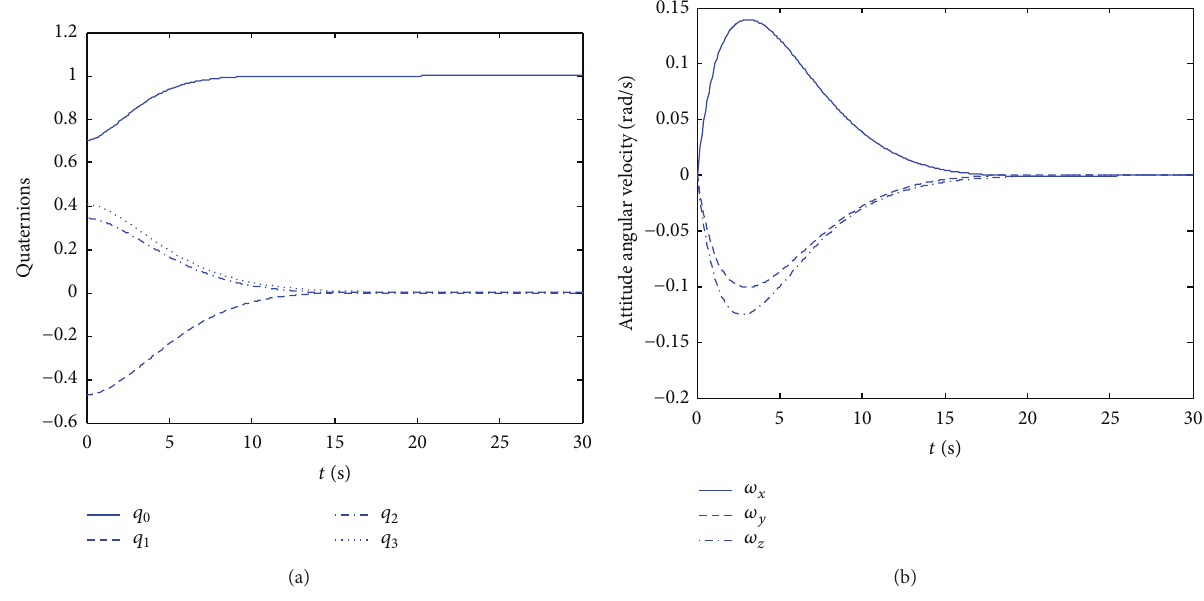
Figure 4: The curves of attitude quaternion and attitude angular